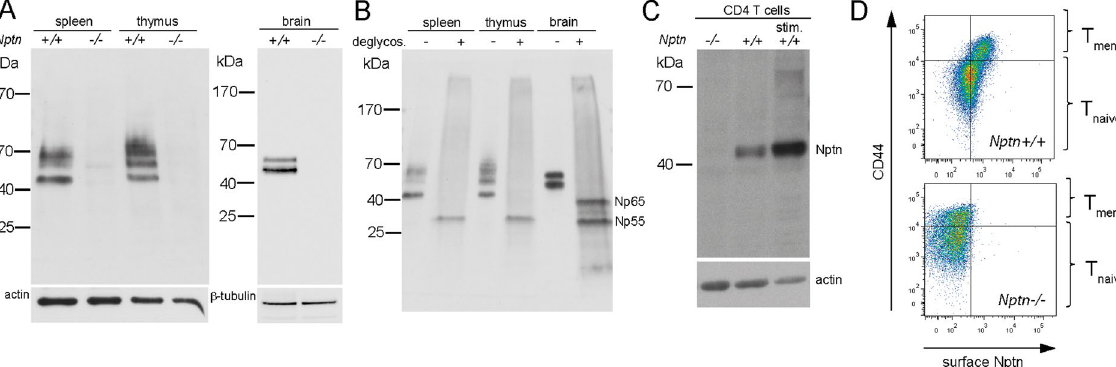
Figure 1. Expression of Neuroplastin in T cells. ( A ) Western blot detection of Neuroplastin in spleen- and thymus-derived Triton X-100 solubilized membrane fractions (30 μ g/ lane) and brain control samples (10 µ g) from Nptn + / + and Nptn − / − mice. ( B ) Western blot analysis of Neuroplastin before and after deglycosylation detected in spleen and thymus samples (15 µ g each) and brain control samples. Bands of ~28 and ~40 kDa represent non-glycosylated Np55 and Np65. ( C ) Western blot detection of Neuroplastin (Nptn) in naïve and activated T cells reveals an apparent molecular weight of ~45 kDa and strong upregulation upon stimulation by culturing on immobilized anti-CD3/anti-CD28. ( D ) FACS analysis of Neuroplastin surface expression. Plots show Neuroplastin expression levels on CD44 − naïve and CD44 + memory CD4 T